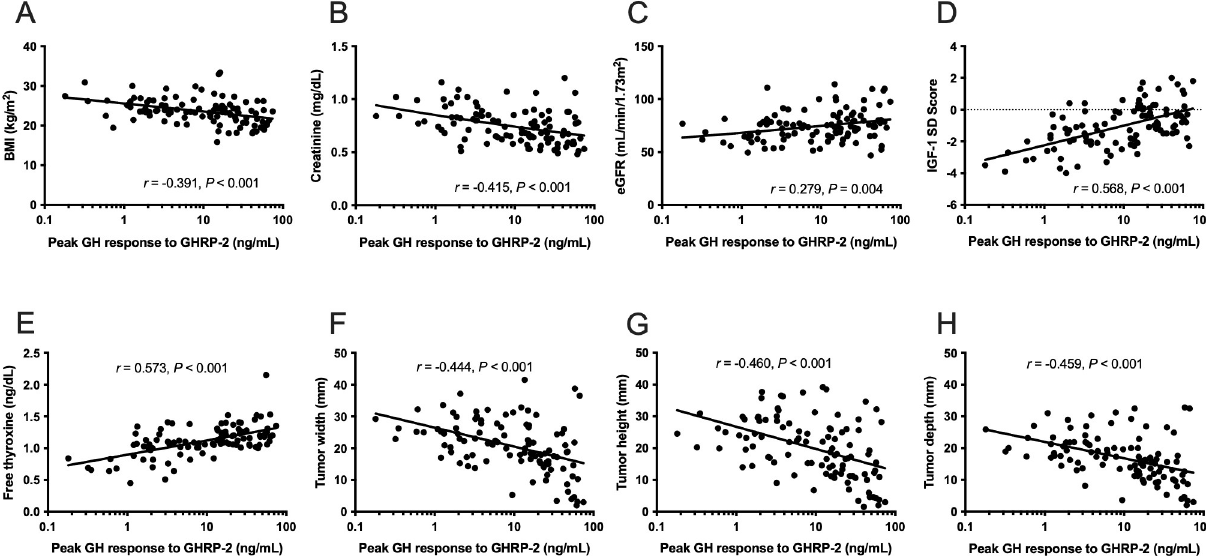
Fig 2. Background characteristics and peak GH response to GHRP-2. (A) BMI, (B) serum creatinine level, and (F) tumor width, (G) height, and (H) depth significantly correlate negatively with peak GH response to GHRP-2. (E) Estimated GFR, (D) IGF-1 SD score, and (E) free thyroxine levels significantly correlate positively with peak GH response to GHRP-2. GH, growth hormone; GHRP-2, growth hormone-releasing peptide-2; BMI, body mass index; GFR, glomerular filtration rate; IGF-1 SD, insulin-like growth factor 1; SD, standard